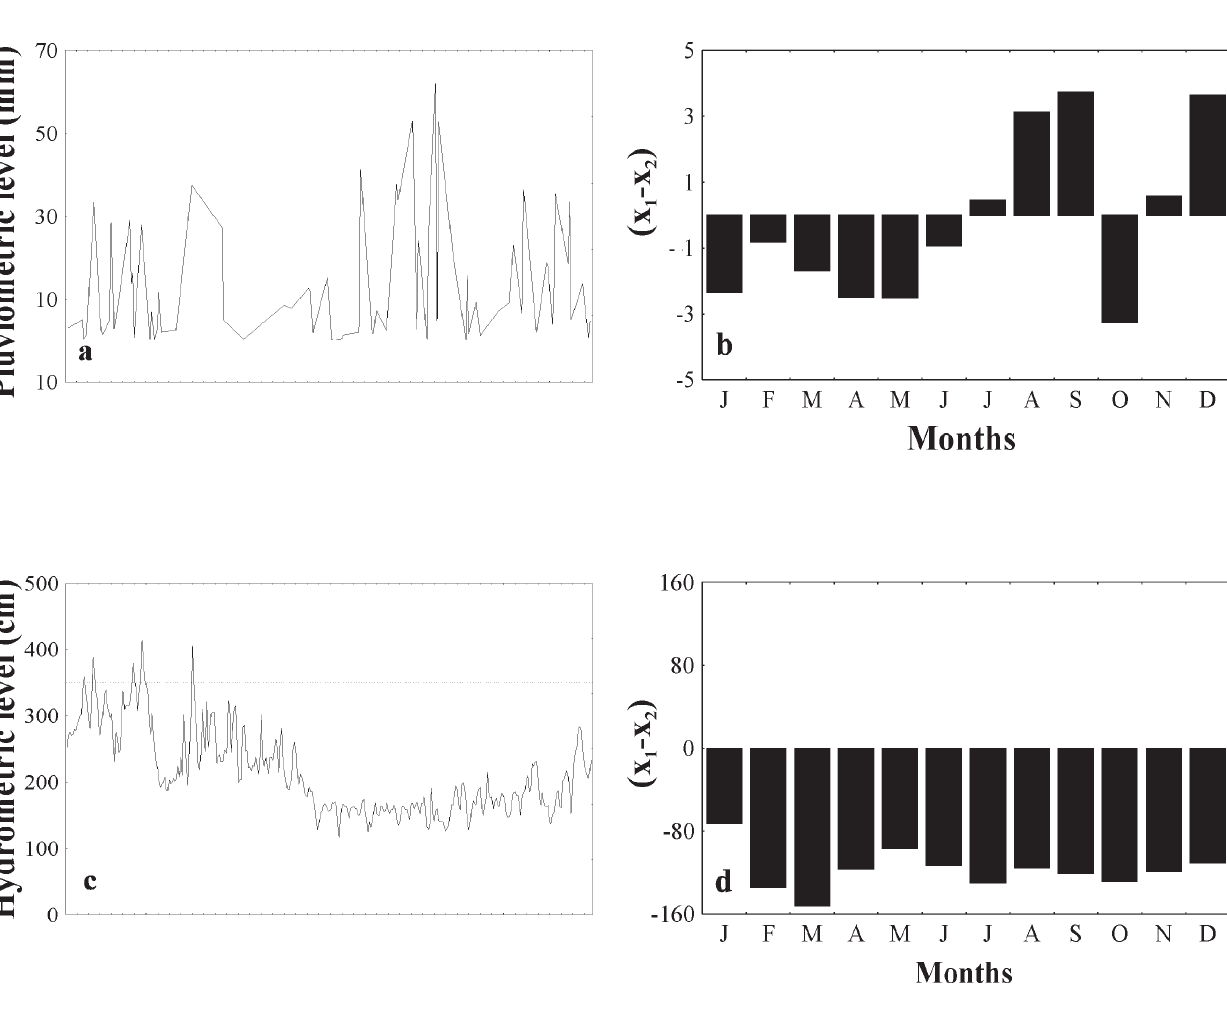
Fig. 2. Daily variation of pluviometric (a) and hydrometric levels (c) of the Paraná River in 2000, measured at Porto São José municipality, and difference between mean monthly pluviometric (b) and hydrometric levels (d) in 2000 (x years (x ). Data supplied by DNAEE (Departamento Nacional de Águas e Energia Elétrica). Dashed line indicates water level 2 required for initial inundation of the floodplain (Veríssimo,